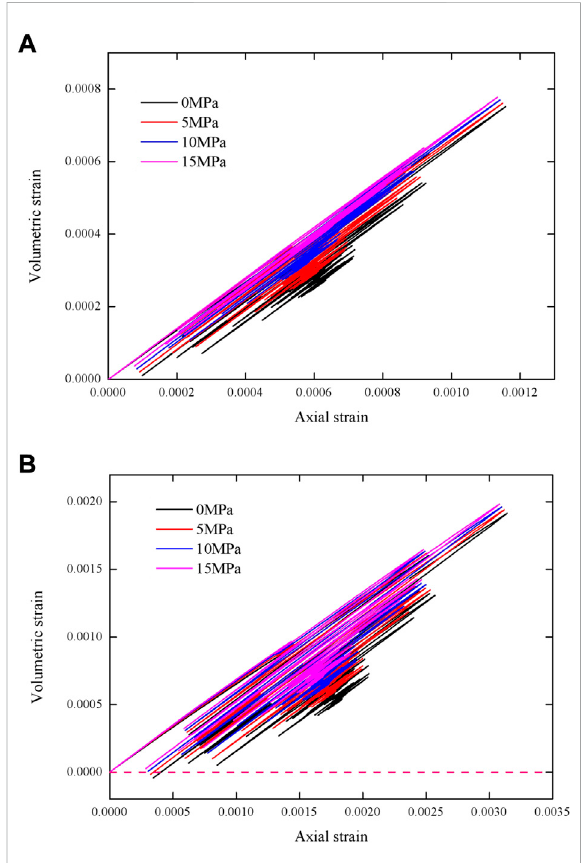
FIGURE 4 The volumetric strain-axial strain curves of the rock under Kobeseismicloadwithdifferentcon fi ningpressures: (A) Maximum stress of 30 MPa; (B) Maximum stress of 80 MPa.